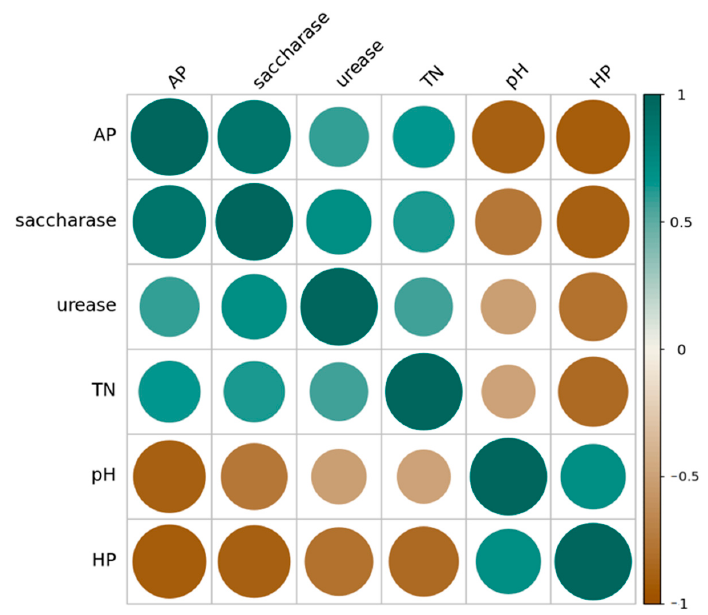
Figure 5. Pearson correlation between soil enzymatic activity, soil pH, and soil nutrients across all land use types and soil depths in the Taojia River basin. Note: brown—darker colors and larger circles indicate p -values closer to − 1 and a more significant correlation between the two indicators. Green—darker colors and larger circles indicate p -values closer to 1 and a more significant correlation between the two indicators.